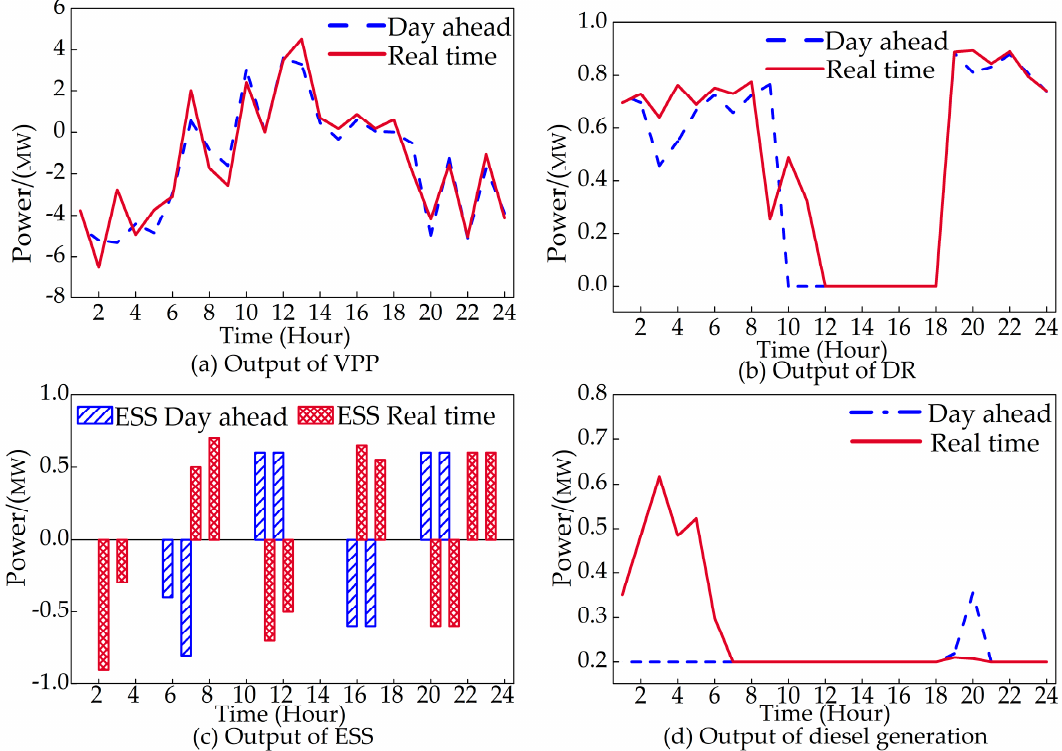
Figure 8. Operational status of the VPP.